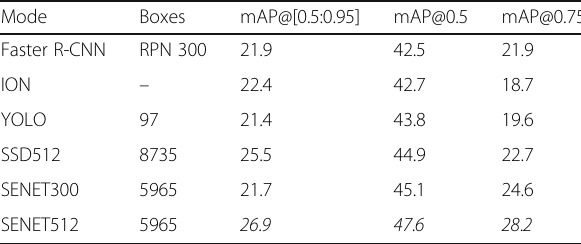
Table 2 Testing results of MS COCO show that SENET model performs well in small